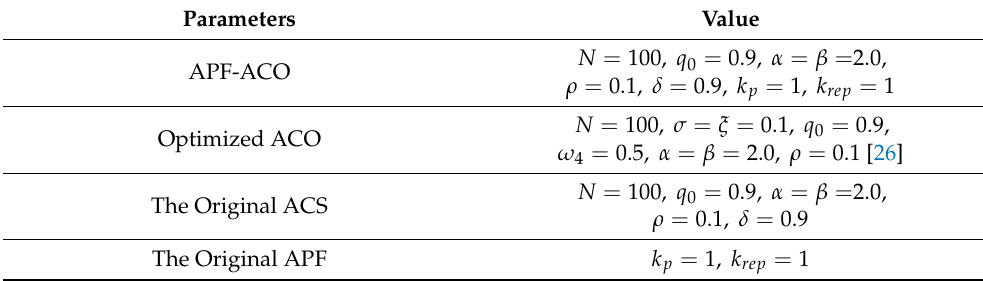
Table 3. Parameter Settings.